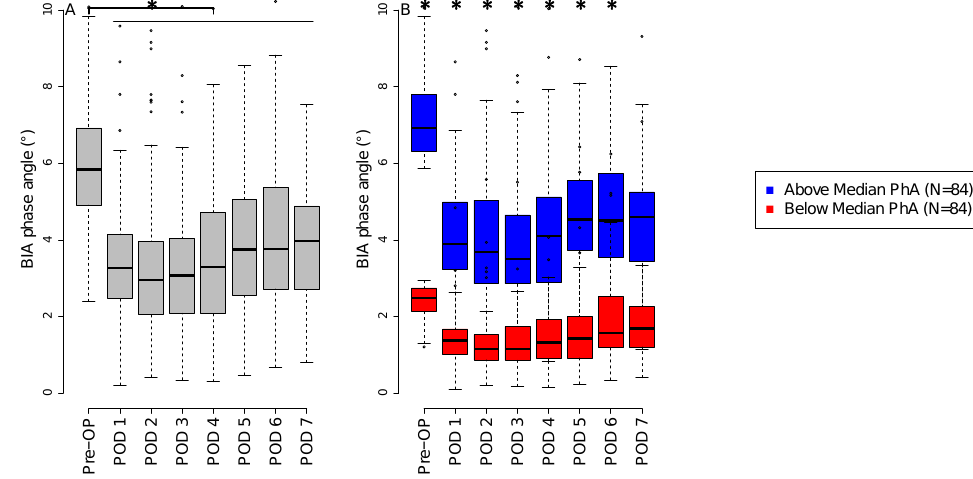
Figure 2. Perioperative phase angle. ( A ) The boxplots show the perioperative course of phase angle at different time points. ( B ) The boxplots show the difference between patients’ perioperative course of high (blue) vs. low (red) preoperative phase angles at different time points. Asterisks mark significant differences between the two groups at a p -value of less than 0.05. In the boxplots, the lower boundary of the box indicates the 25th percentile, a black line within the box marks the median, and the upper boundary of the box indicates the 75th percentile. Whiskers above and below the box indicate the 10th and 90th percentiles. Points above and below the whiskers indicate outliers outside the 10th and 90th percentiles. Abbreviations: BIA, bioelectrical impedance analysis; Pre-OP, pre- operative; POD, postoperative day.